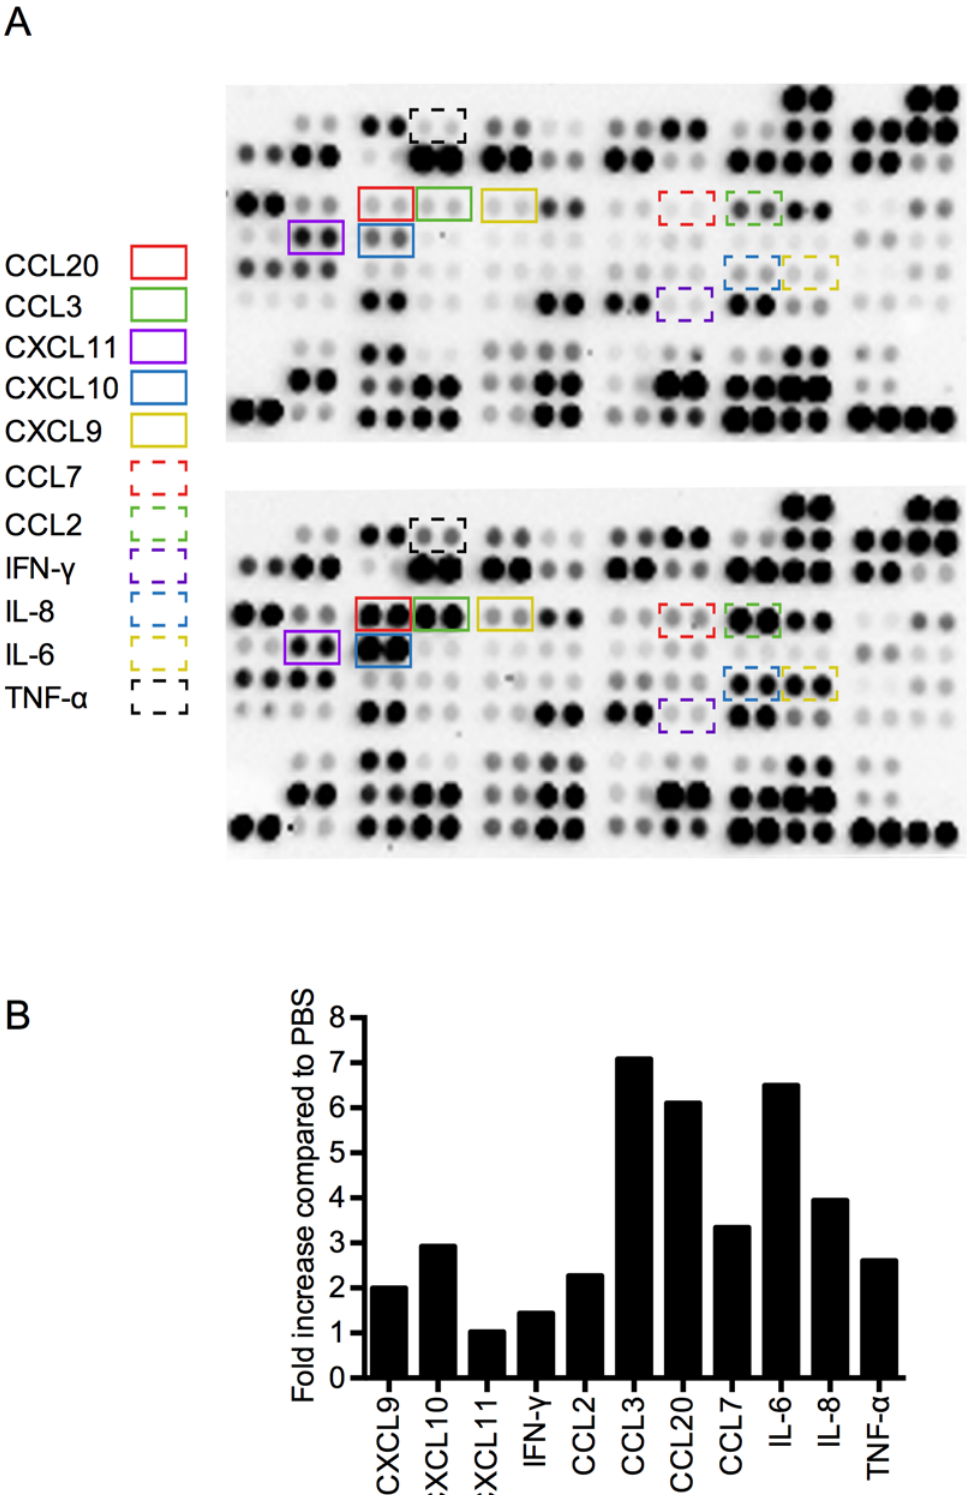
Fig 1. Cytokine imprint of blood stimulated with CTHs. (A) Human heparinized blood was stimulated with CTHs (60 μ g/ml) or PBS. After a 12-hour incubation time, samples were centrifuged and the resulting plasma was analyzed using a multi-cytokine membrane array. Mean pixel densities